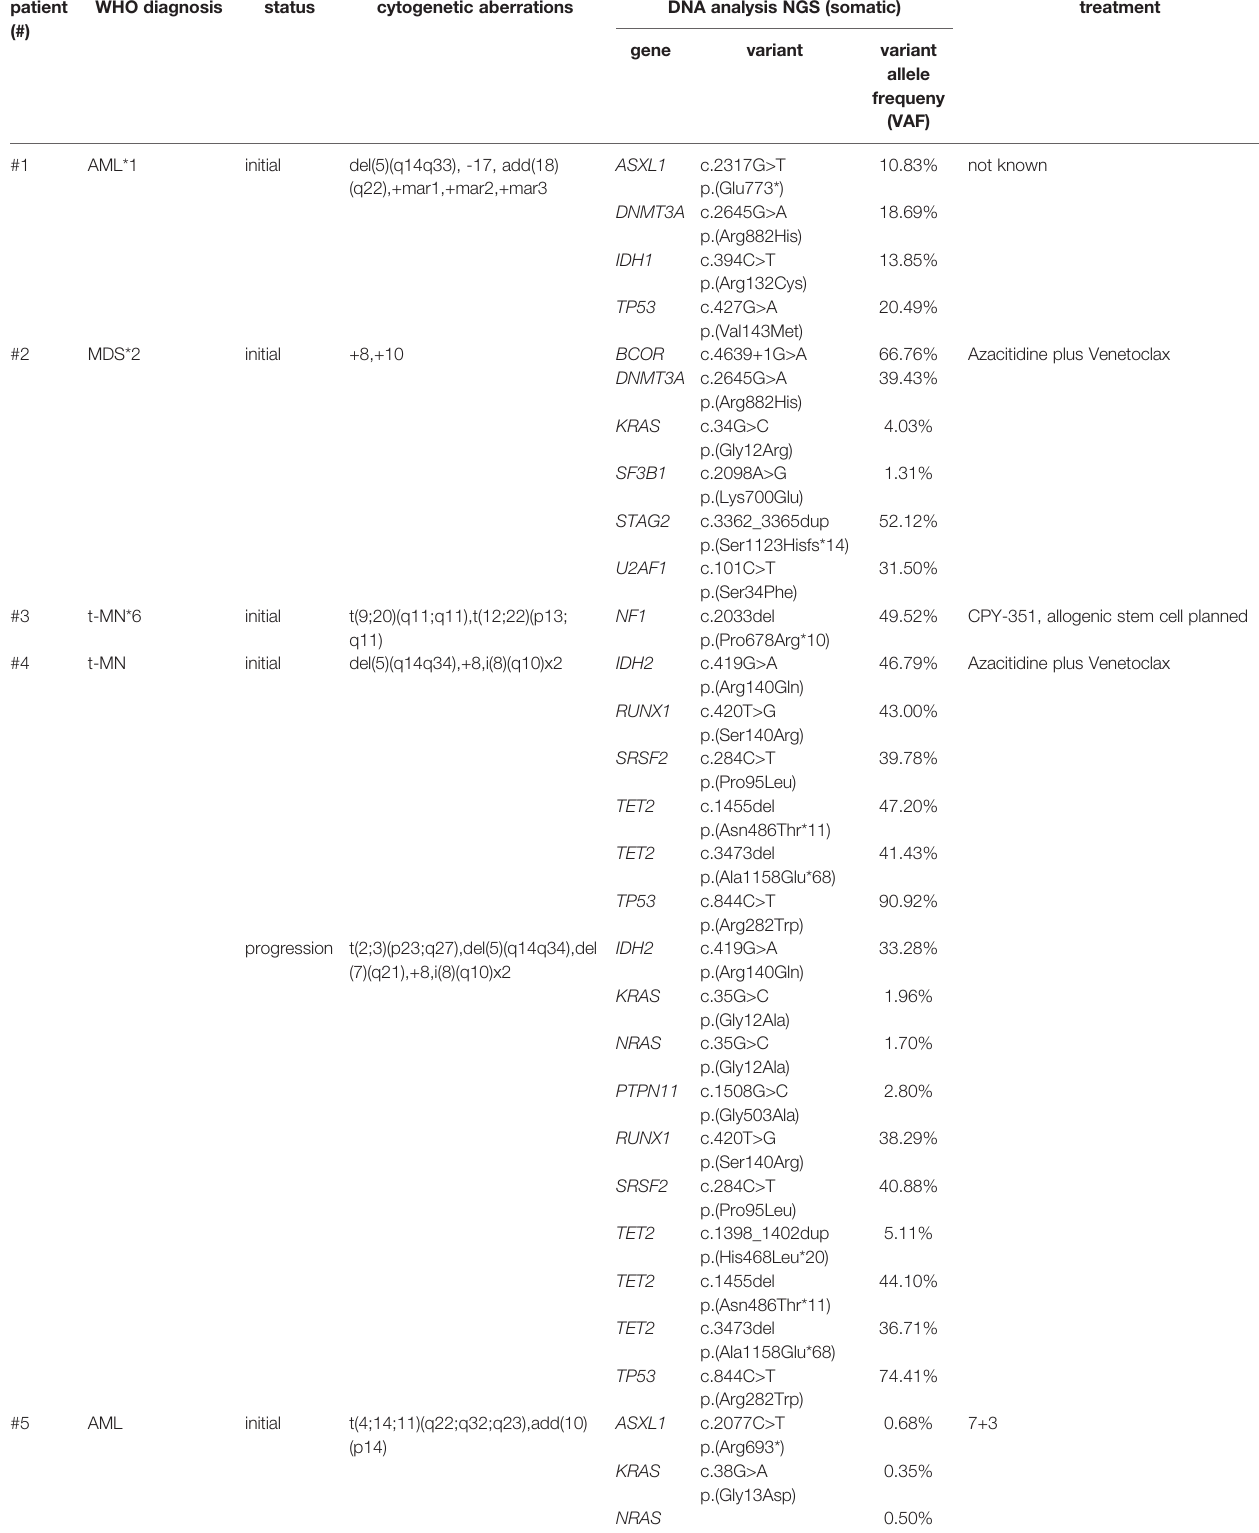
TABLE 1 | Overview of analyzed patients (n=8) (All results of performed analyses as well as clinical data are shown in Table S1